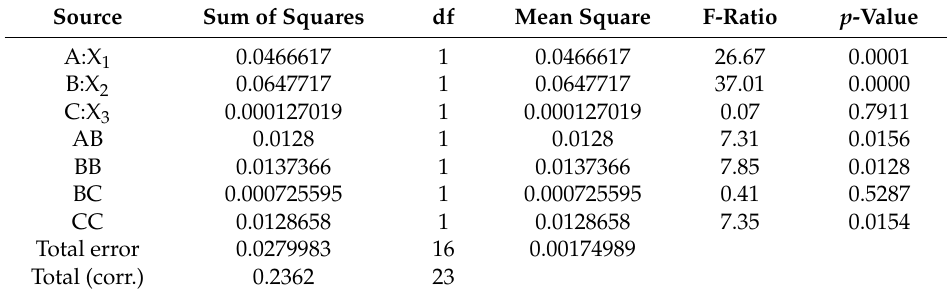
Table 3. ANOVA for wheat straw